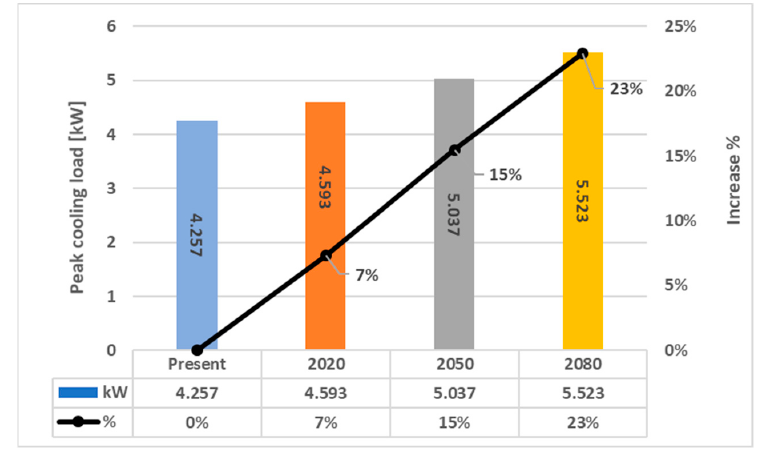
Figure 10. Peak cooling load for the present and the predicted future in Hurghada. The increase in the external dry bulb temperatures will lead to a decrease in the split system performance, as shown in Figure 11. This decrease in performance will lead to a faster rate of increase in the electricity consumptions as shown in Figure 12.